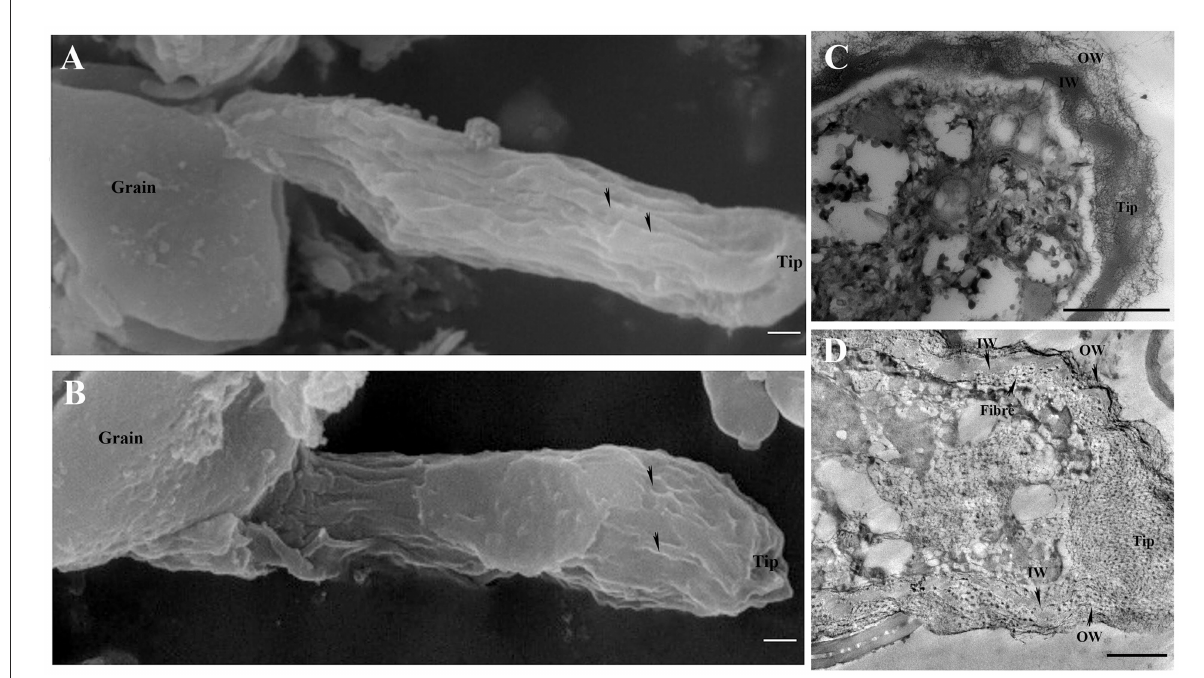
FIGURE4 Effects of B toxicity on the ultrastructure of C . mollissima pollen tubes. (A) Scanning electron micrograph (SEM) of the control pollen tube. (B) SEM of B toxicity-treated pollen tube. (C) TEM transverse section of the control pollen tube. One layer (fibrous wall) exited in the tips, but two layers (fibrous pectic layer in the OW and callose layer in the IW) exited in the tubes. (D) TEM transverse section of B toxicity-treated pollen tube. The disorganized fibrous wall existed at the pollen tube tip. And the OW and IW were crosslinked and fiber exited inside of IW. OW, Outer wall; IW, inner wall. Bar = 3 µ m in A and B; Bar = 1 µ m in (C,D) . The arrows indicated longitudinal furrows in A and